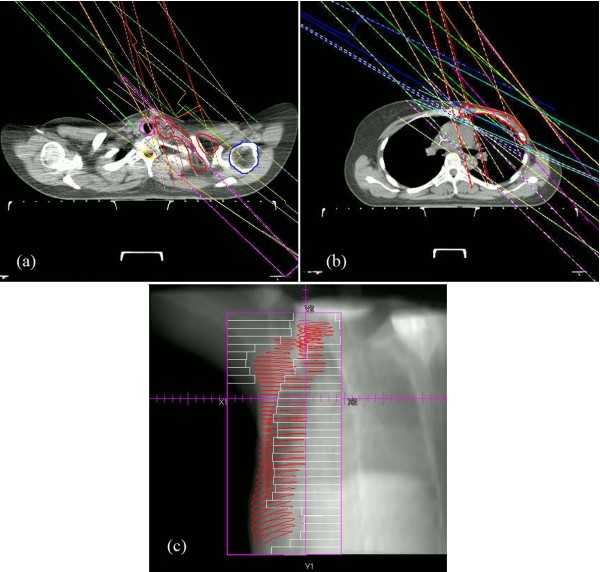
A 7-beam integrated plan designed for a patient with left breast cancer: (a) beam angles (115, 125,135, 300, 315, 330, and 345 degrees) for supra/infraclavicular region; (b) identical beam angles for chest wall and IMN; (c): lateral beam’s-eye-view (BEV) of the whole PTV with multi-leaf collimator (MLC)-defined port displayed.